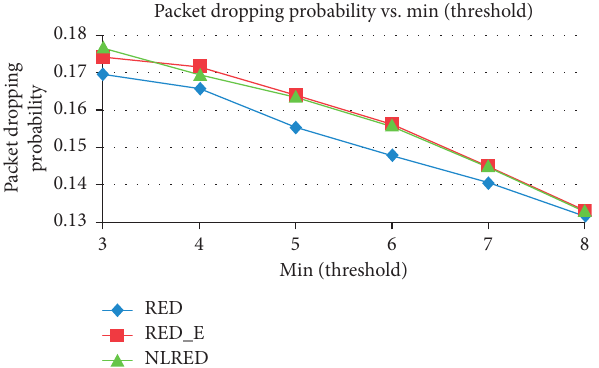
Packet dropping probability vs. min (threshold)